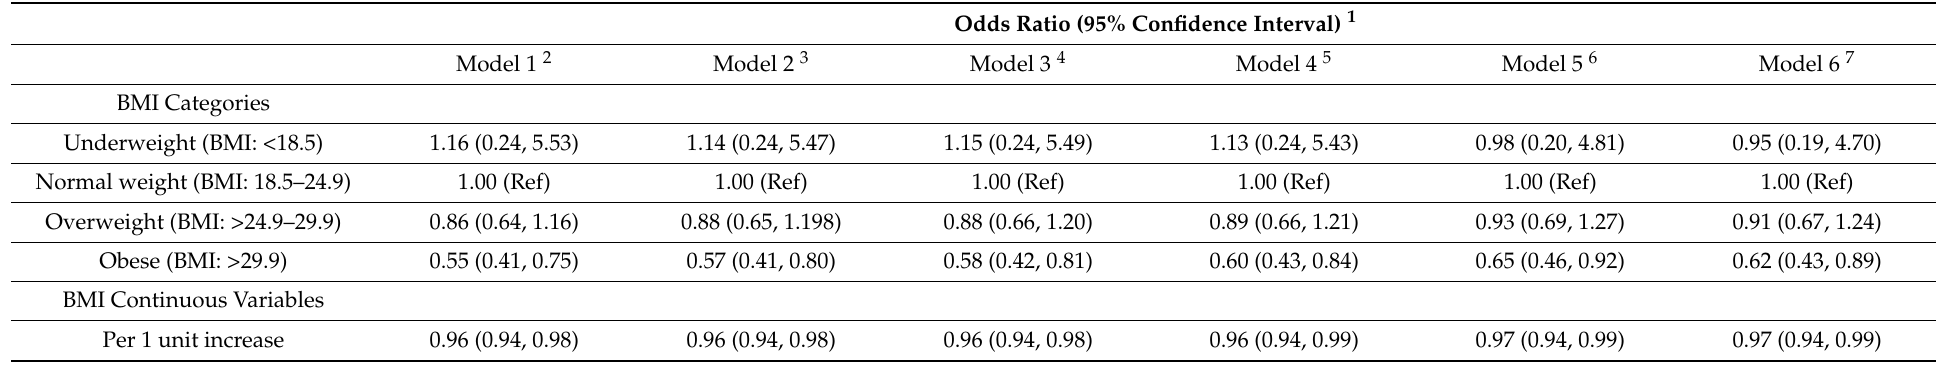
Table 3. Association of BMI and interval breast cancer diagnosed within 1 year after last normal mammogram screening compared to screening-detected breast cancers.